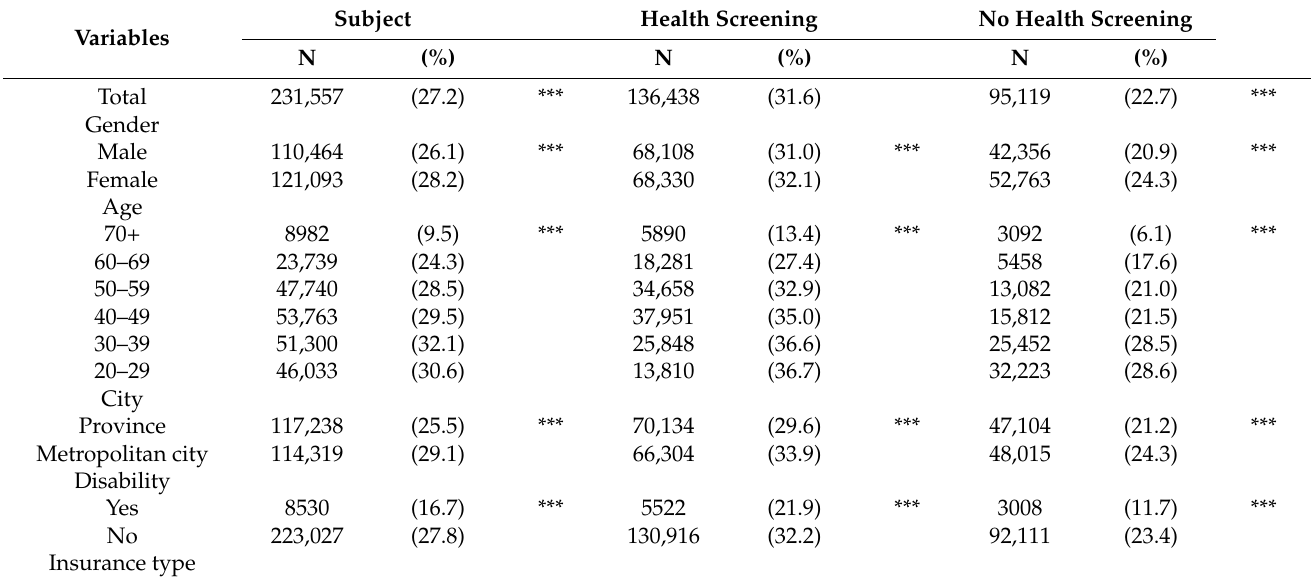
Table 2. The distribution of study sample with scaling between 2014 and 2015 in the National Health Insurance Sharing Service